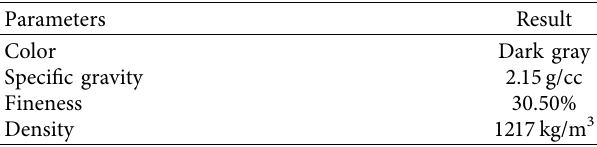
Table 3: Physical properties of bamboo leaf ash.